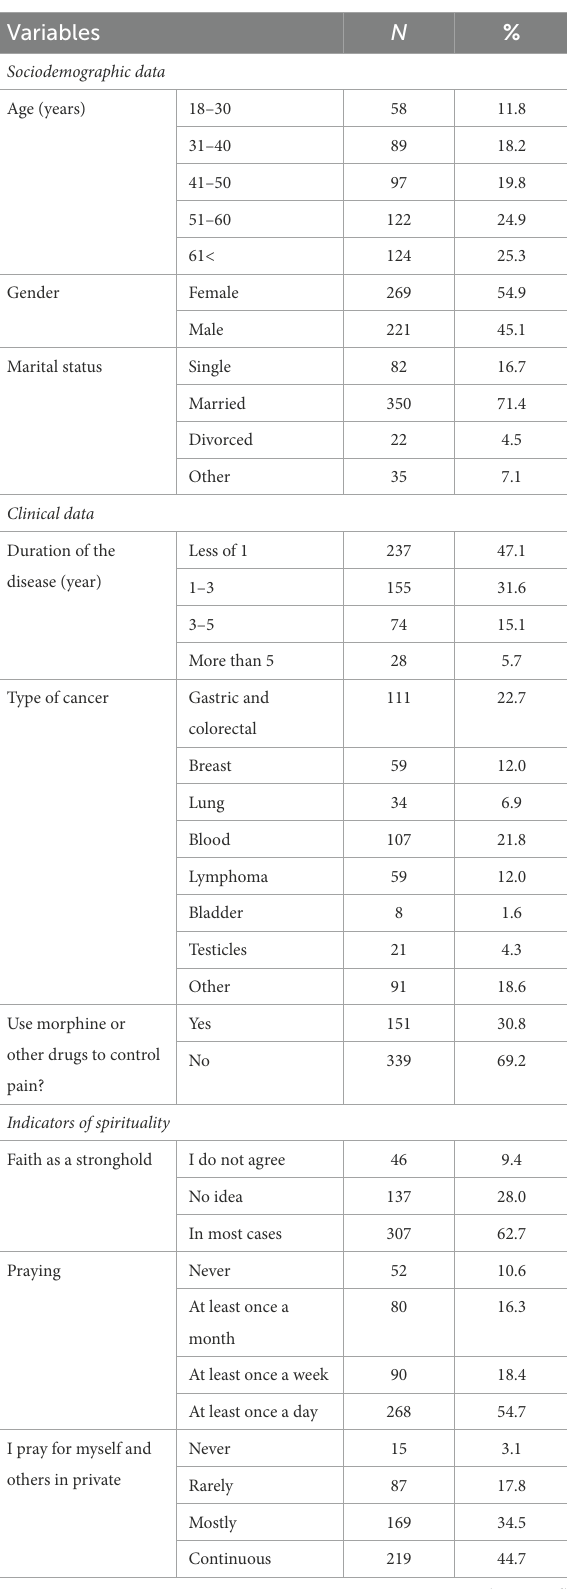
TABLE 1 Demographic and clinical characteristics of the participants (n =